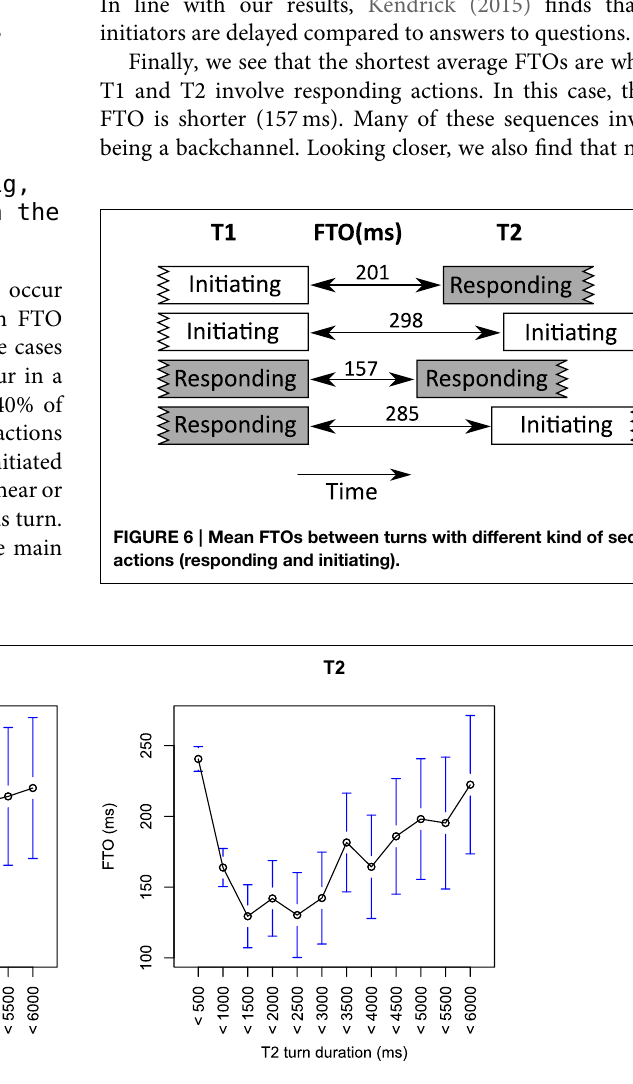
FIGURE 5 | The relationship between FTO and T1 and T2 duration. The data is grouped into 500ms bins. Circles represent the mean of the bin, with bars showing the 95% confidence intervals.